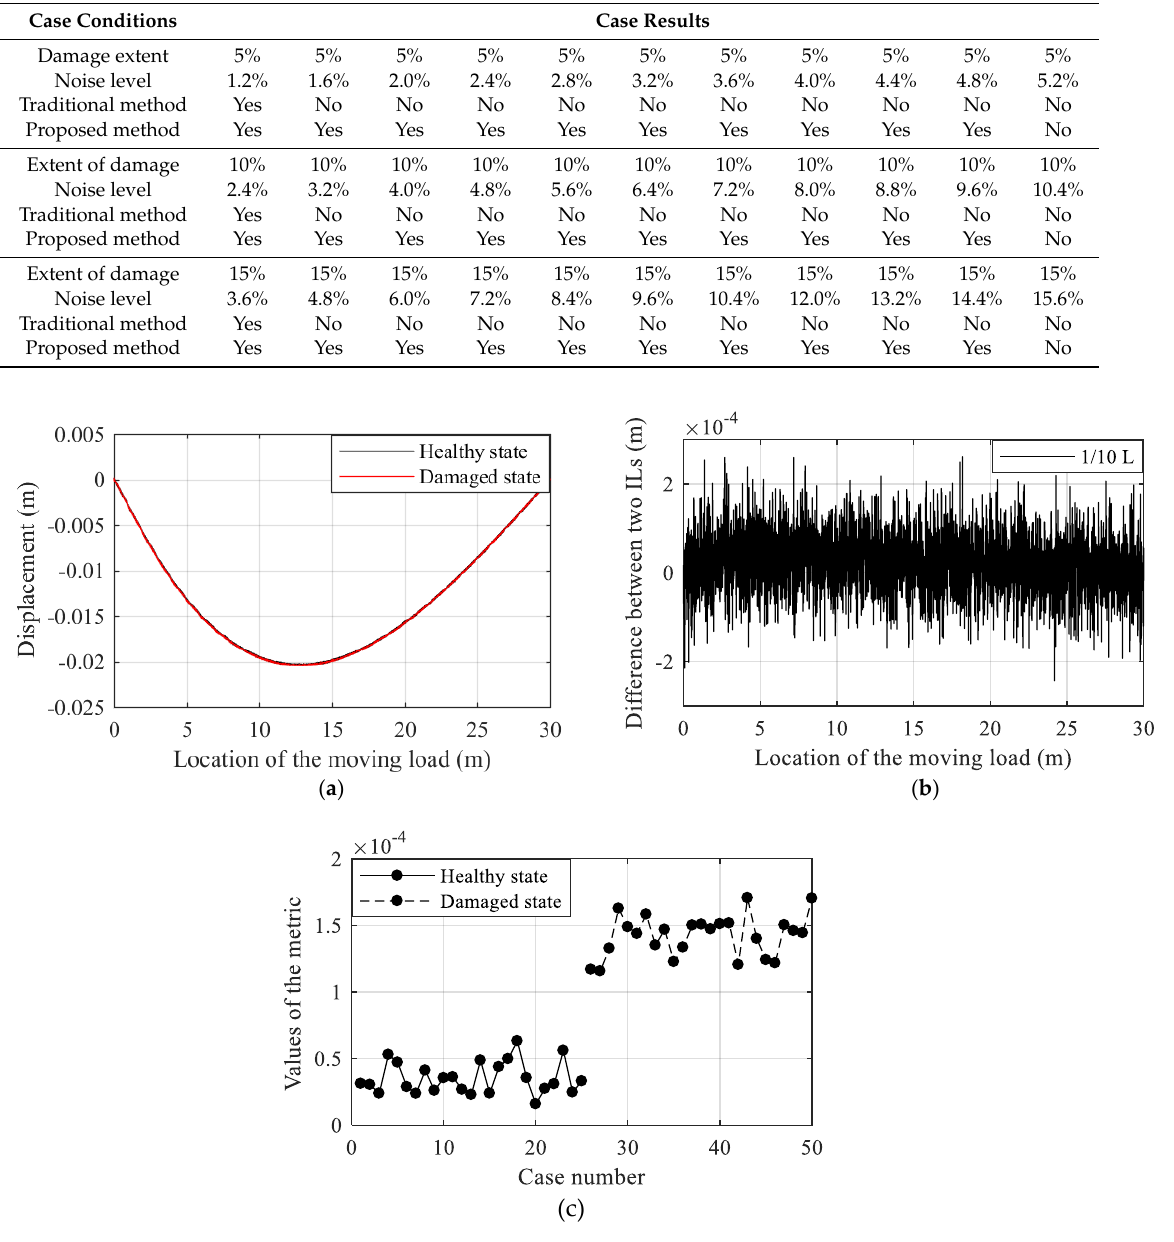
Table 3. Description of all cases for the quasi-static load test of the model bridge.